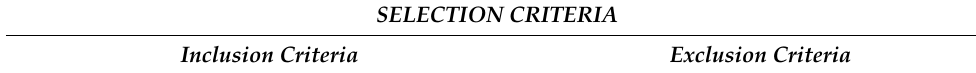
Table 1. Selection Table 1. Selection Criteria.